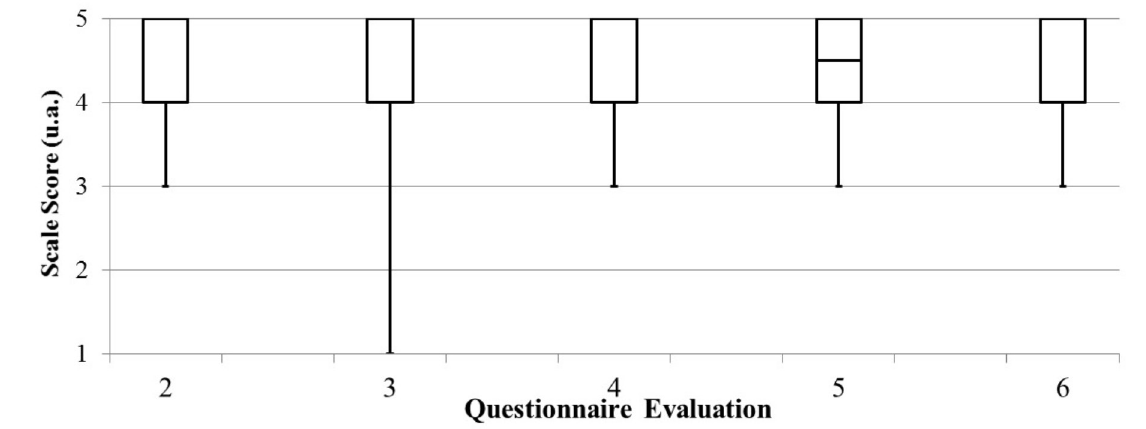
Figure 5: Median, 1st and 3rd quartile values and maximum and minimum values for the Questionnaire Evaluation itens. Where: (2) Clarity of questions; (3) Relevance of questions; (4) Reliability of questions; (5) Importance of information; (6) Satisfaction with the